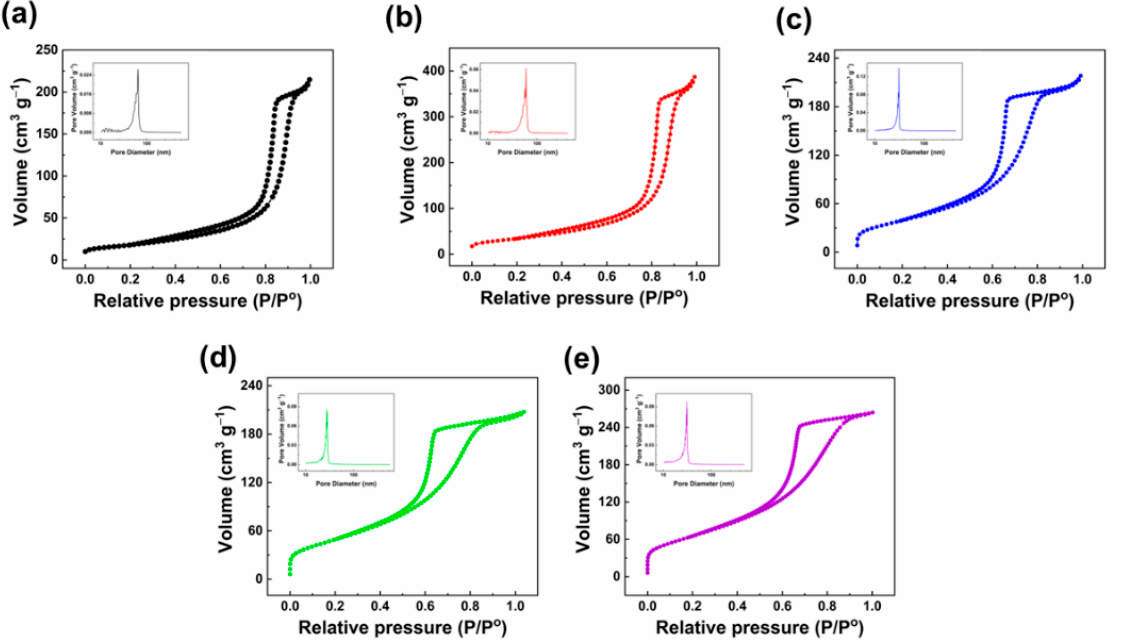
Figure 3. N 2 physisorption isotherms of ( a ) TiO 2 , ( b ) TiO 2 -Mo-0.9, ( c ) TiO 2 -Mo-1.5, ( d ) TiO 2 -Mo-2.2, and ( e ) TiO 2 -Mo-3.1. The inset figures represent the pore sizes distribution curves. Table 1. The textural properties of investigated samples as evaluated from EDX analysis, XRD,